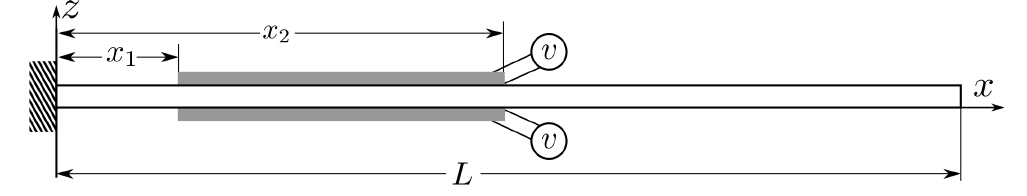
Figure 6. Three-layered beam with two smaller piezoelectric beams of the same width (shown as gray color) as the non-piezoelectric beam (shown as white color). Beam length L = 60 mm; piezoelectric layer thickness t p = 0.5 mm, and the thickness of the non-piezoelectric beam was t b = 1.0 mm; and the applied voltage v = 100